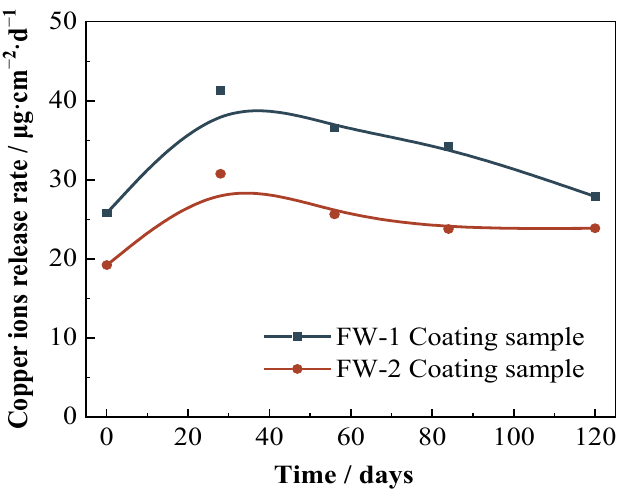
Figure 11. Copper ions release rate curves of two coating samples.